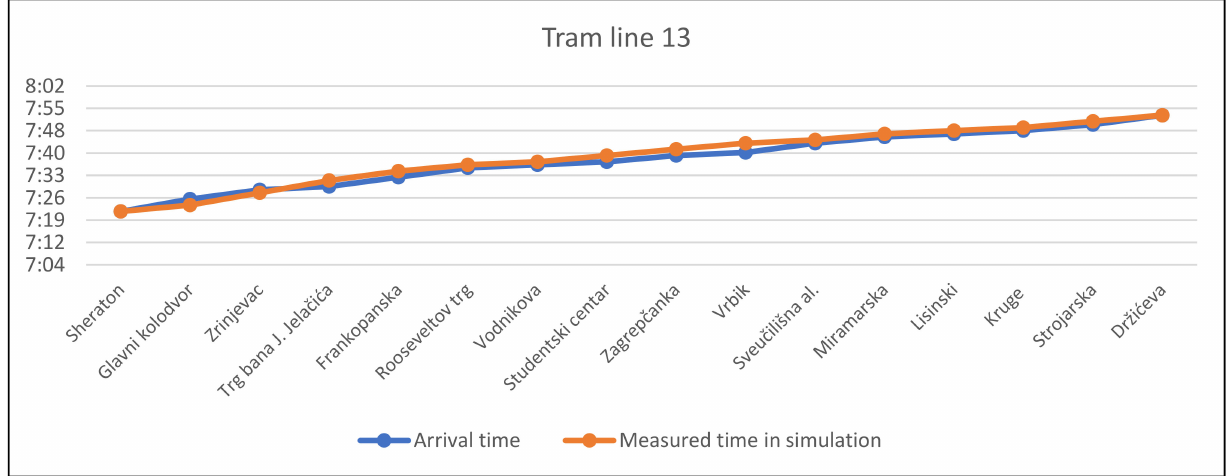
Figure 7. Comparison of arrival time and measured time in simulation of tram line